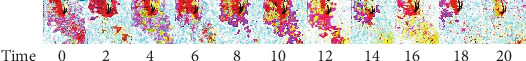
Colorimetric changes of the RGB-converted images of the film with 25% anthocyanin extract per time of exposure in minutes to ammonia vapor.